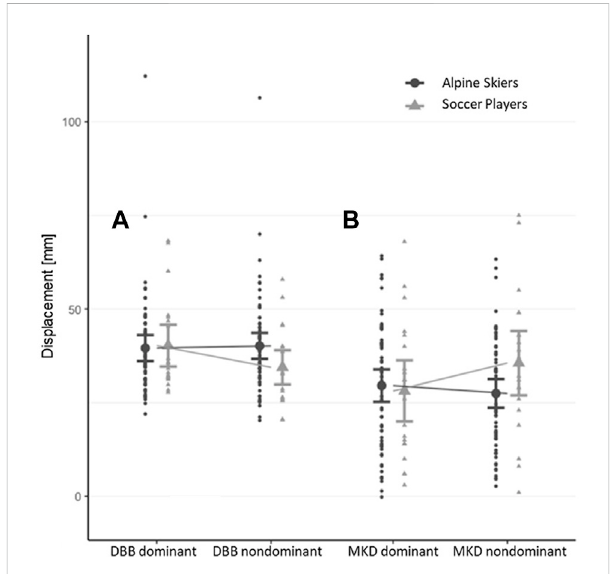
FIGURE 1 (A,B) Diagram with population mean, 95% CI, and individual values for deadbug bridging (DBB) and medial knee displacement (MKD). (A) Pro fi le diagram for the interaction effect side*sports with respect to the maximum amplitude of the vertical displacement of the two pelvis markers during DBB exercise, with the marker of the stabilizing side representing the reference marker (DBB displacement ). (B) Pro fi le diagram for the interaction effect side*sports withrespect to